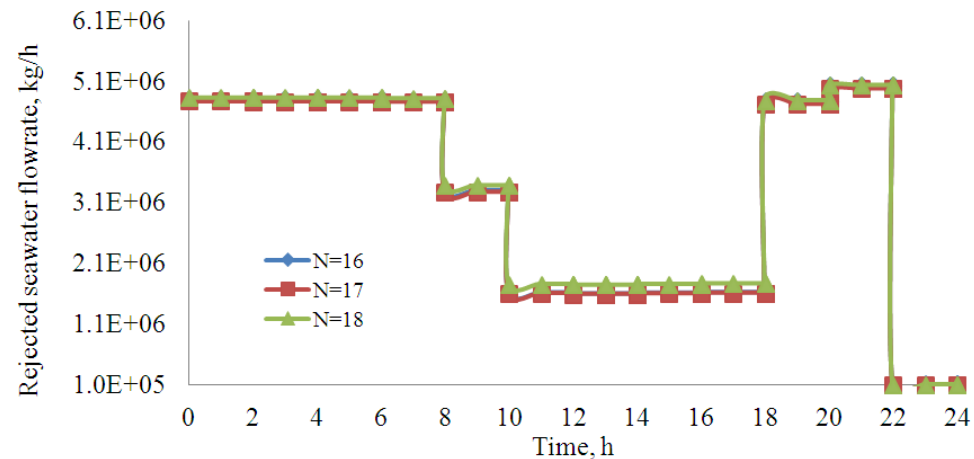
Figure 7. Optimum rejected seawater flow rate throughout profile. Note: In y axis, E+05 = 10 5 and likewise.